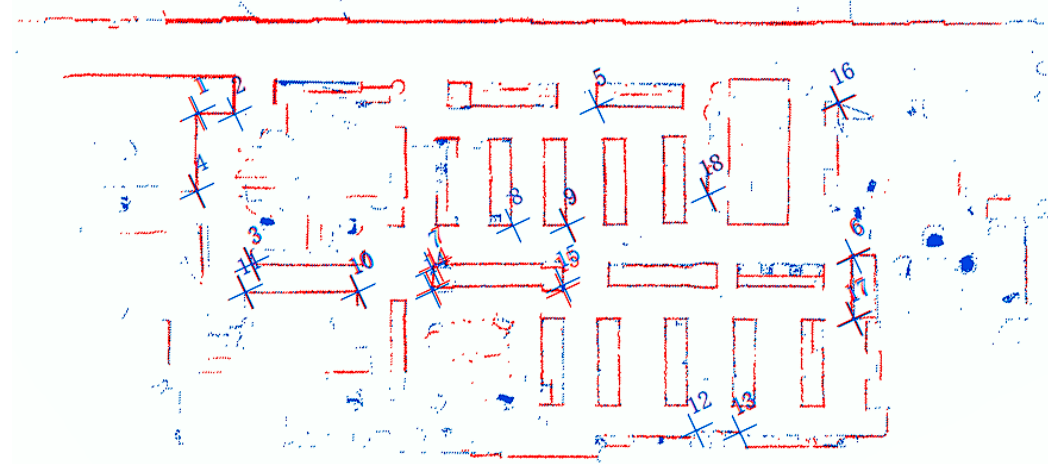
Figure 9. The occupancy likelihood maps, generated by our platform (red) and TLS (blue) in the TLSs’ coordinate frame. Cross marks and numbers represent 18 correspondence feature points. Table 1. The residual error (cm) of the 18 feature points. Residual_x and residual_y are residual errors of the x-coordinate and y-coordinate, respectively, and residual is the root mean square of residual_x and residual_y.